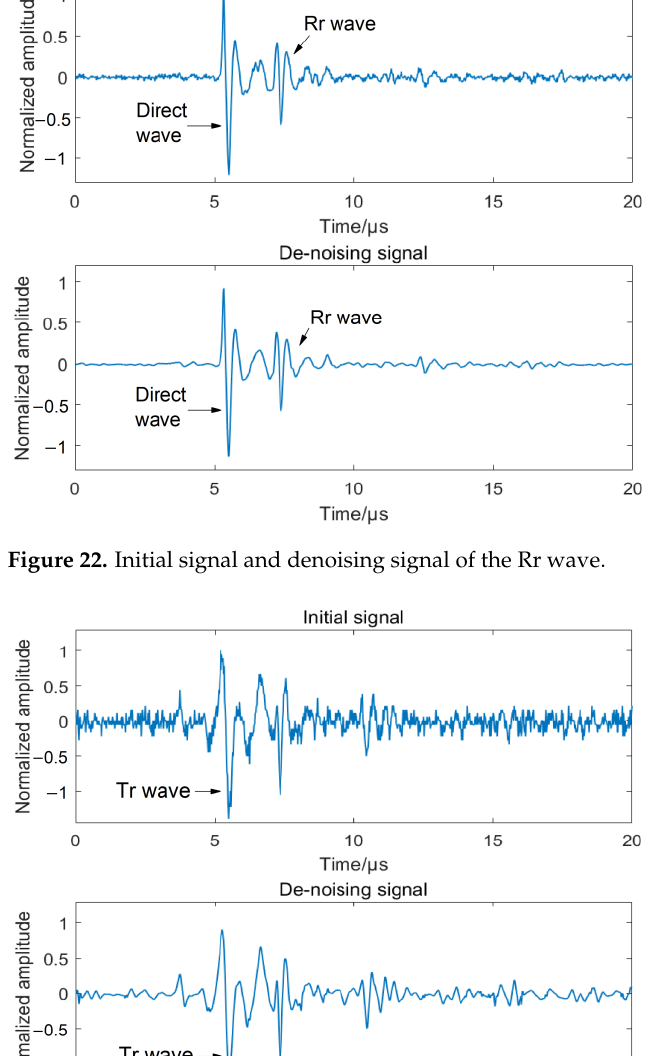
Figure 24. Experimental data and fitting line of the normalized feature parameter versus angles. Figure 25. Experimental data and fitting line of the normalized feature parameter versus depth. In Figures 24 and 25, the normalized feature parameters of the experimental data are denoted by dots, and the fitting lines are denoted in red. The determination coefficients of